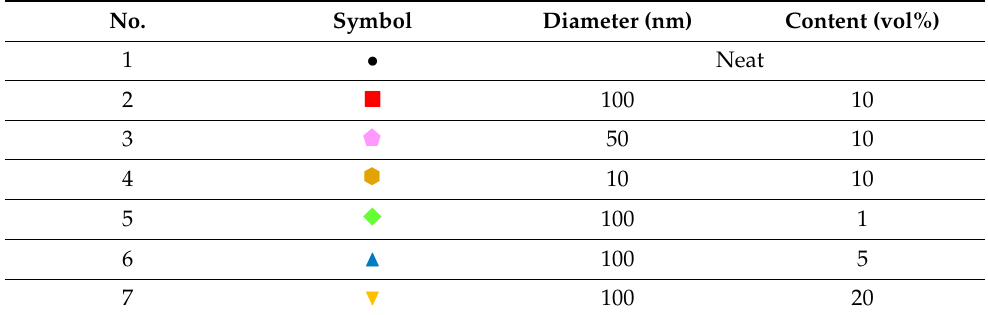
The color symbols do not apply to Figures 4 and 5.